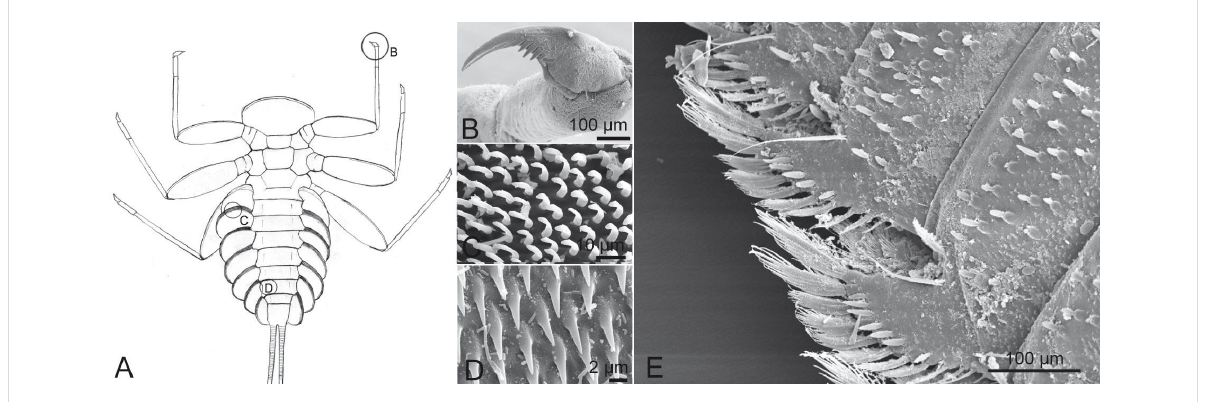
Figure 6: (A–D) Attachment devices of E. assimilis larvae: (A) ventral view, (B) claw of the foreleg, (C) setae of the pads on the ventral side of the gill lamellae, (D) areas with spiky acanthae on the lateral parts of the abdominal sternits. Reproduced with permission from [26]; (E) Structure on the distal edge of the ventral side of the beetle larva Elmis s p. Reproduced from [18].